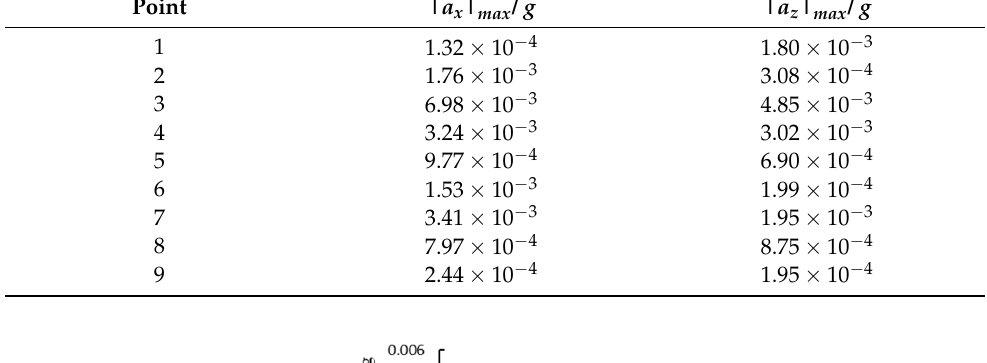
Table 3. Eigenvalue of acceleration of east injection inclined shaft.